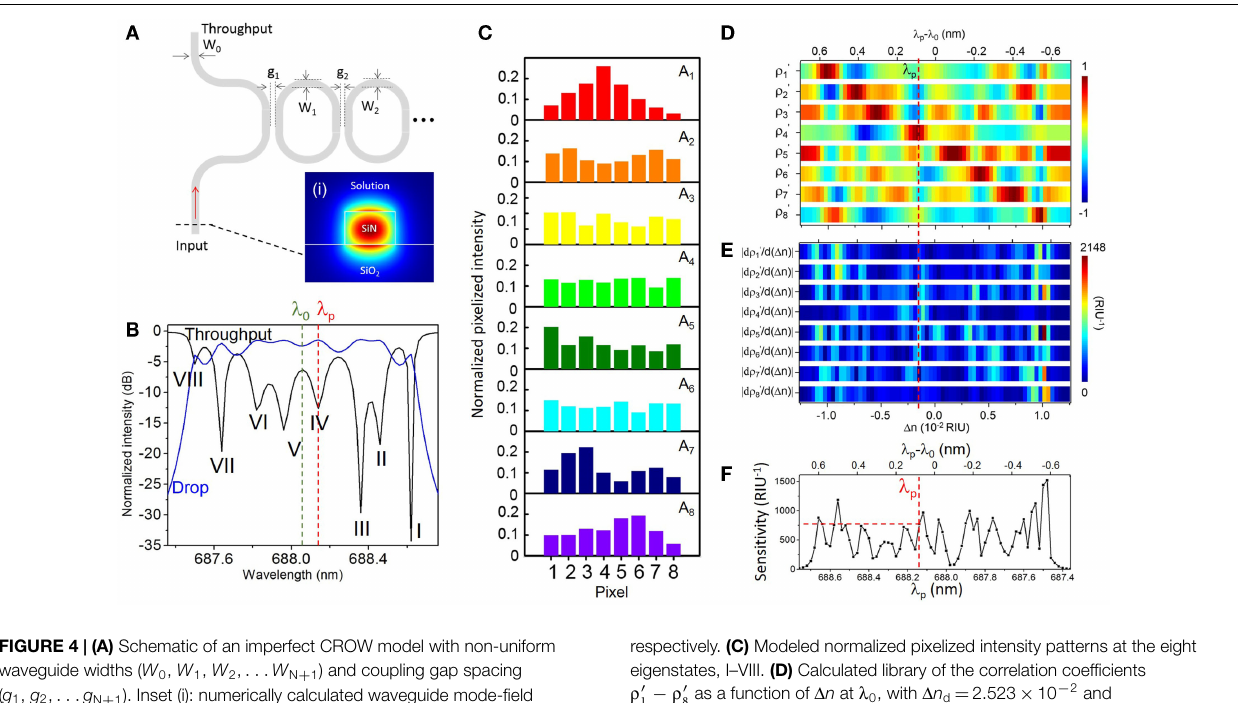
FIGURE 4 | (A) Schematic of an imperfect CROW model with non-uniform waveguide widths ( W 0 , W 1 , W 2 , ::: W N + 1 ) and coupling gap spacing ( g 1 , g 2 , ::: g N + 1 ). Inset (i): numerically calculated waveguide mode-field amplitude profile in the TM mode. (B) Modeled throughput- and drop-port transmission spectra of an imperfect eight-microring CROW using transfer-matrix modeling. Green and red dashed-lines indicate the reference wavelength λ 0 of 688.06nm and the probe wavelength λ p of 688.14nm,